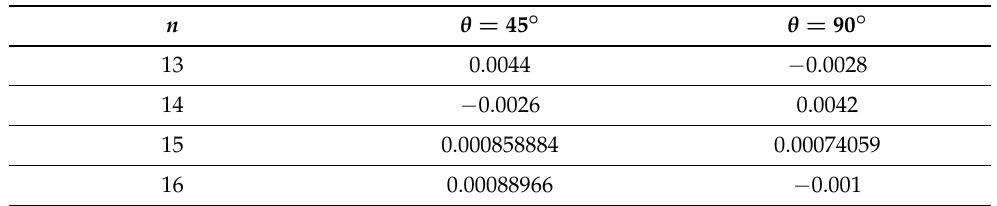
Table 1. CORDIC algorithm results z n